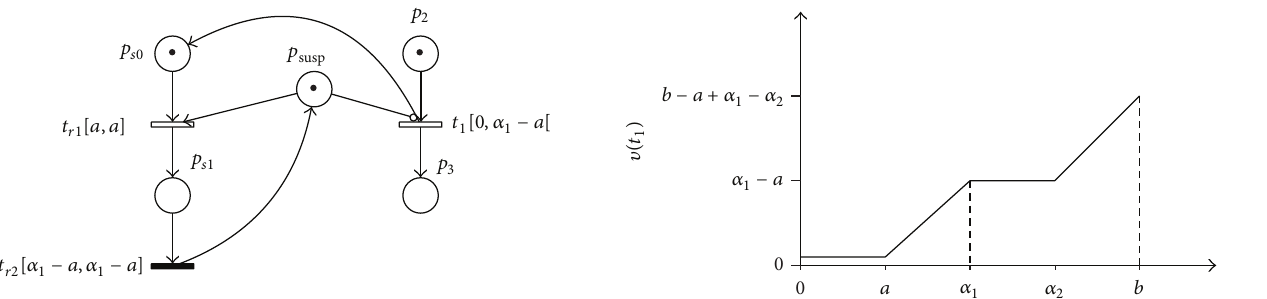
Figure11:ThecontrolledTPNofFigure 10usinginhibitorhyperarcs ( 𝑇 𝑐 = {𝑡 1 }) . Forbidden interval is ]𝛼 1 ,𝑏] where 𝑎 ≤ 𝛼 1 < 𝑏 .